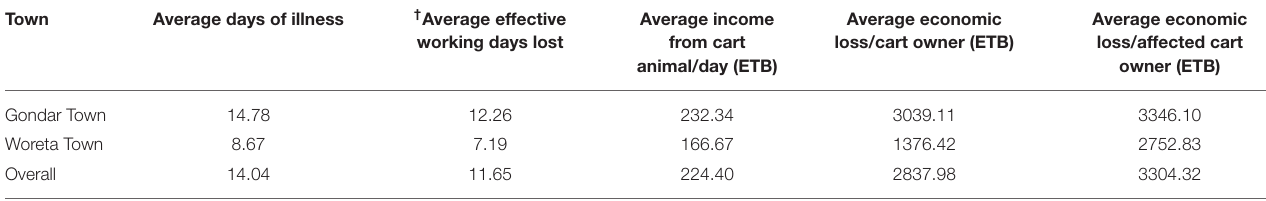
TABLE 2 | Annual economic loss due to working power loss per cart owner and per affected cart owner by town.